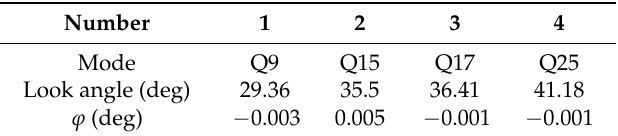
Table 3. Theoretical polarization orientation angles (POAs) of 4 scene data with polarimetric active radar calibrator (PARC).